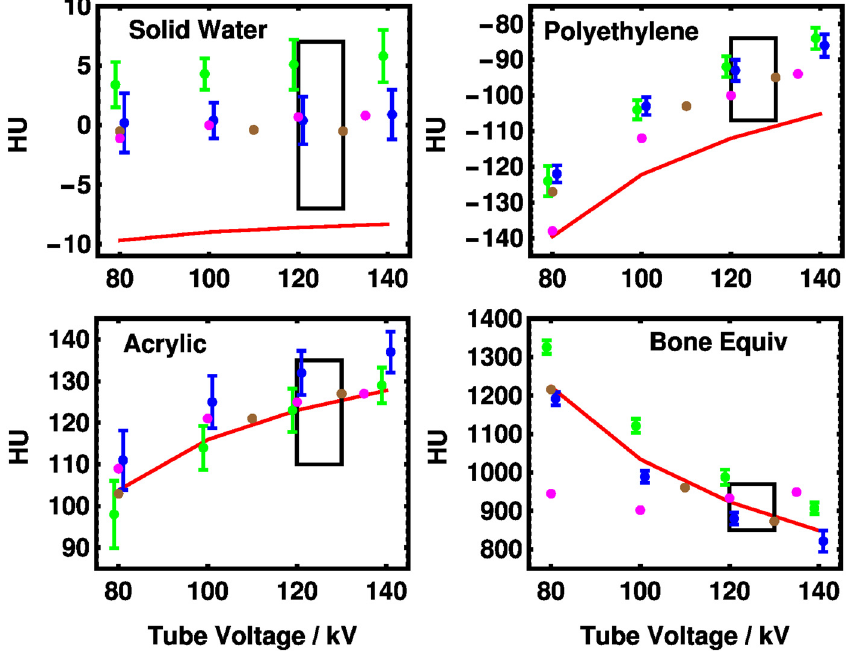
Fig 8. Comparison of model to measurements from the literature. Experimental points are from the measurements of [30] with recommended ranges for 120 kV to 130 kV tube voltages from the American College of Radiology given as black rectangles. The machines are identified in [30] as GE (green), Siemens (blue), Siemens SPECT-CT (brown), and Toshiba (magenta). The data were drawn from 25 GE, 7 Siemens (non-SPECT-CT), 3 Siemens SPECT-CT, and 1 Toshiba scanners. The error bars represent the interquartile ranges reported in the paper for multiple scanners of the same type. Error bars are not given if only a single machine was reported. The values for GE and Siemens have been offset by � 1 kV, respectively, for clarity. The red line is the present theory using mass fractions and densities as specified by the vendor. [29] “Solid Water” is a water equivalent polymer.